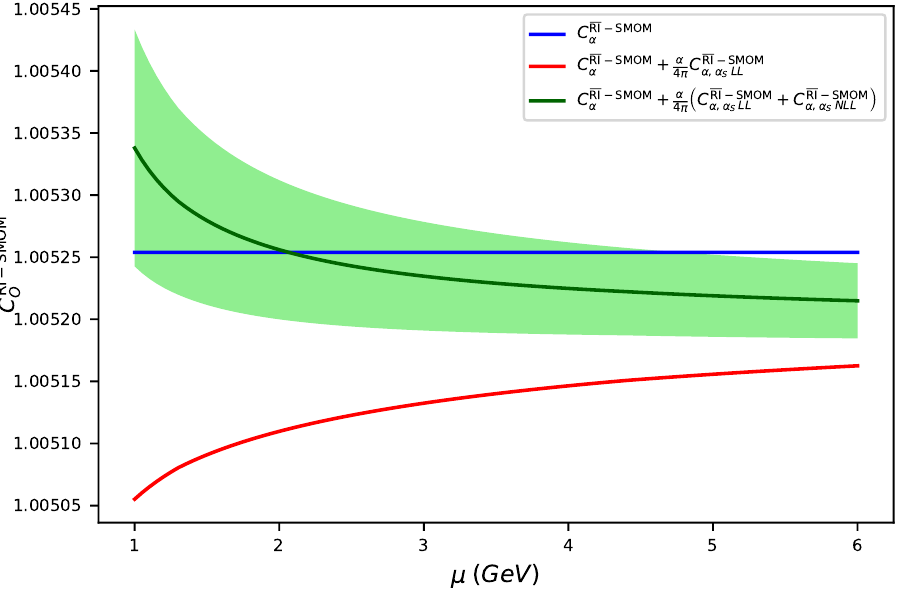
- , where we set SMOM O on the NLL W W